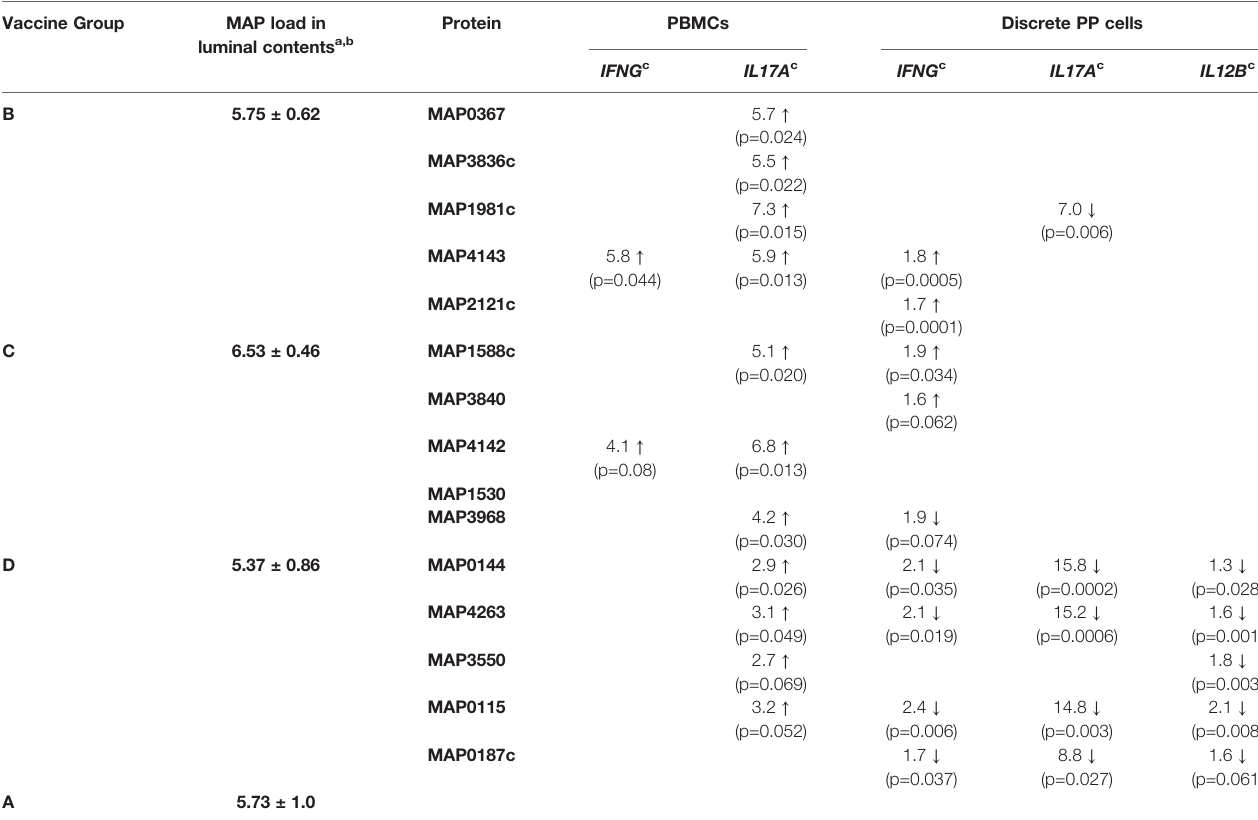
TABLE 1 | Vaccine-induced cytokine responses in peripheral blood and mucosal leukocytes at 28 days post-infection. Vaccine Group MAP load in luminal contents